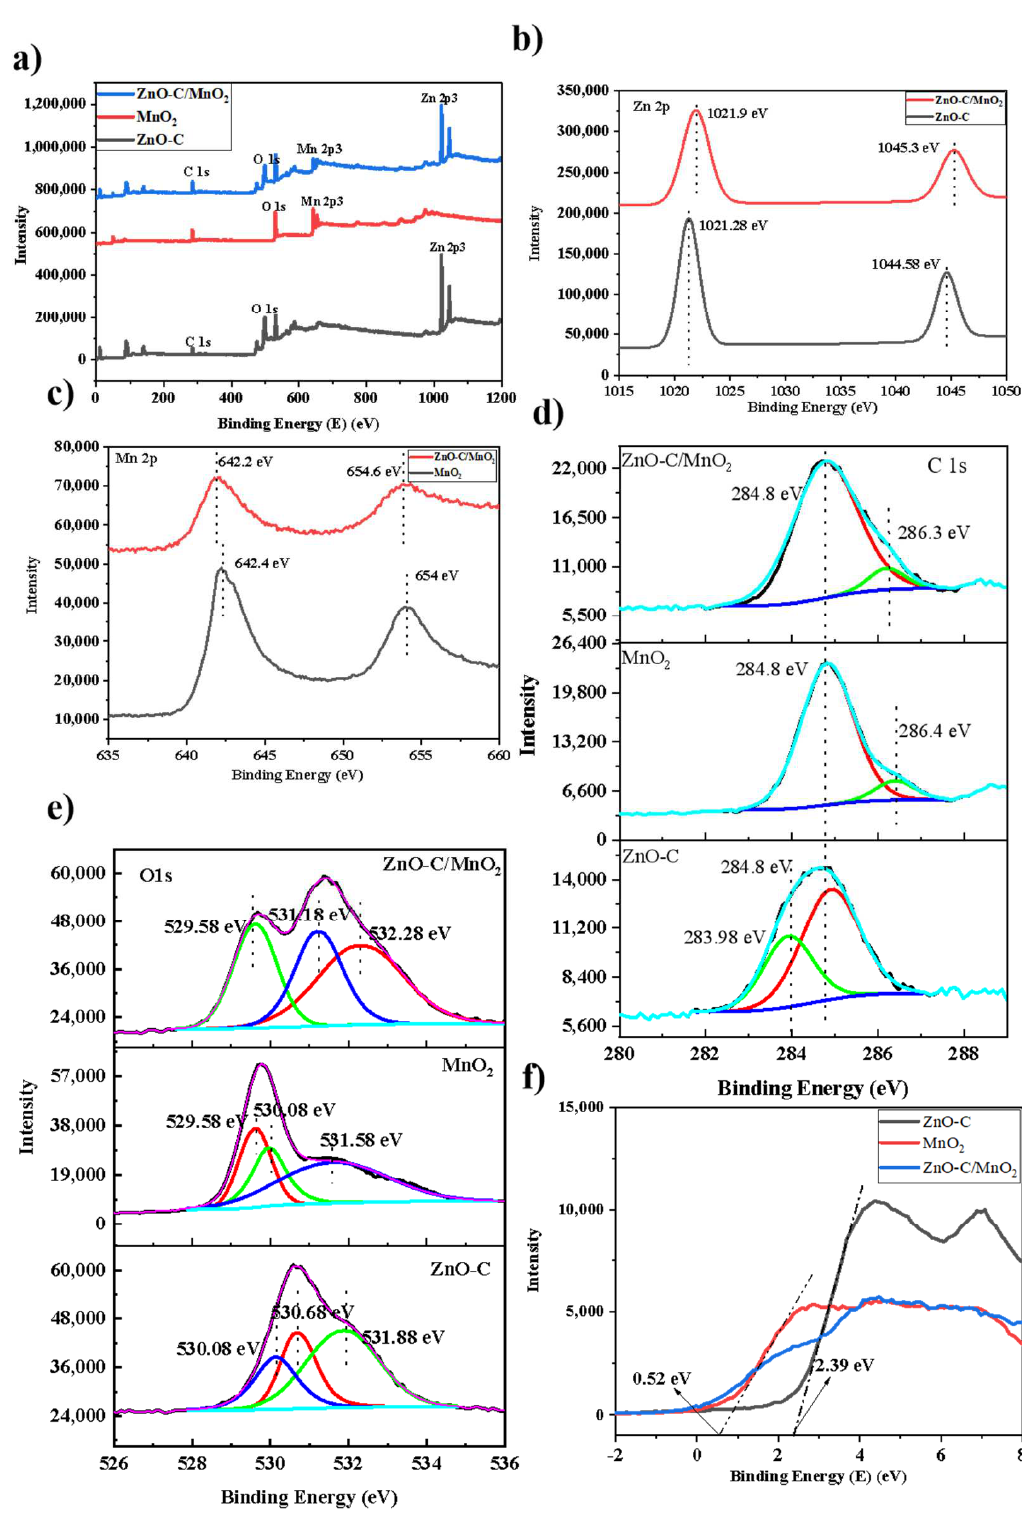
Figure 5. XPS spectra of survey spectra ( a ), Zn2p spectra ( b ), Mn2p spectra ( c ), C 1s spectra ( d ), O 1s spectra ( e ), VB‐XPS of ZnO‐C/MnO 2 ( f ) . The photoluminescence (PL) intensity of a semiconductor can be determined by the recombination of photoinduced carriers. Generally, higher PL intensity means faster recombination of photoelectrons and holes [51]; separation of photocarriers before and after ZnO‐C and MnO 2 nanowire recombination. Figure 6a shows the PL spectra of ZnO‐ C nanospheres and MnO 2 nanowires and ZnO‐C/MnO 2 composites at 370 nm excitation